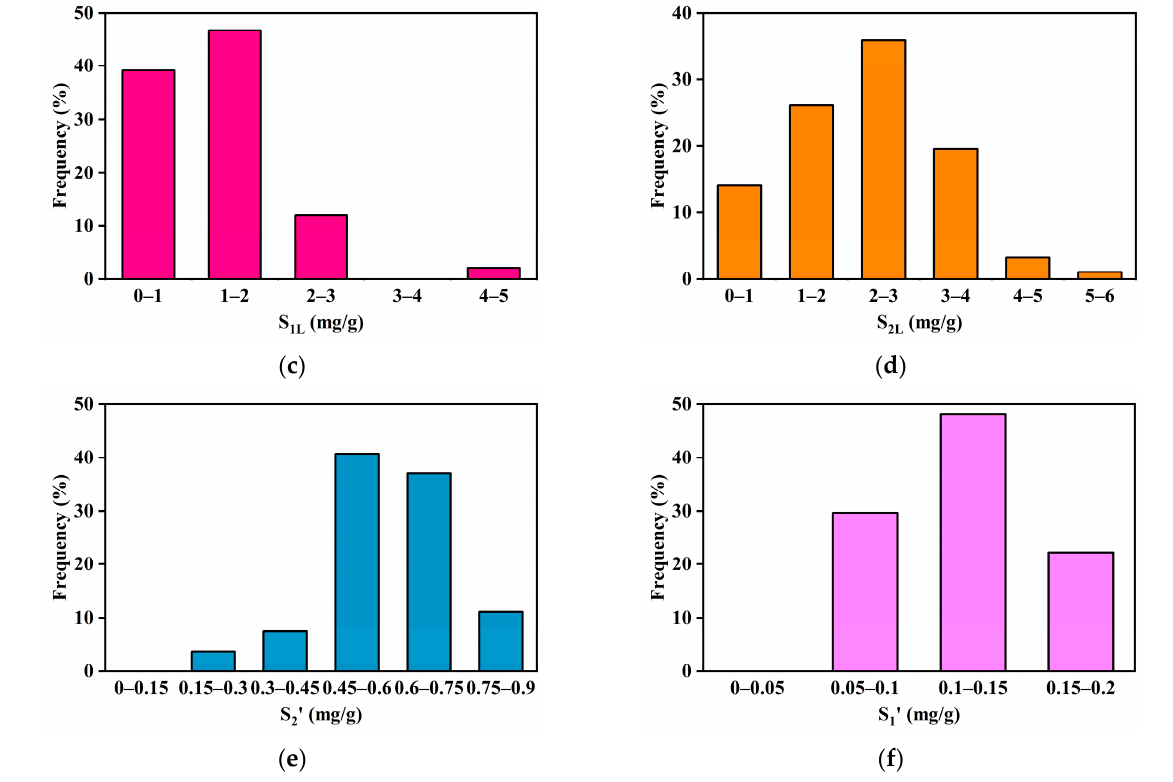
Figure 3. Rock-Eval parameters obtained from the liquefrozen, as-received, and oil-washing shales. ( a ) Distribution of S 1 content. ( b ) Distribution of S 2 content. ( c ) Distribution of S 1L content. ( d ) Distribution of S 2L content. ( e ) Distribution of S 2 ′ content. ( f ) Distribution of S 1 ′ content.